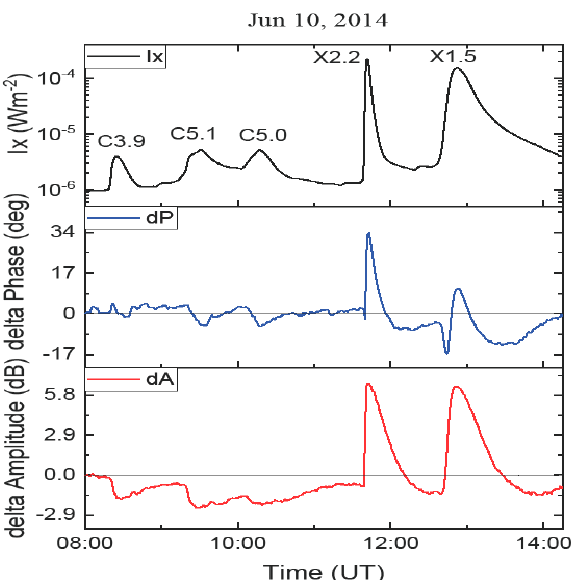
Figure 7. Simultaneous variations of X ‐ ray flux, amplitude, and phase of GQD/22.10 radio signal against universal time during five successive flares on 10 June 2014. ( lower panel ) Perturbation of amplitude; ( middle panel ) Perturbation of phase; ( upper panel ) X ‐ ray flux.